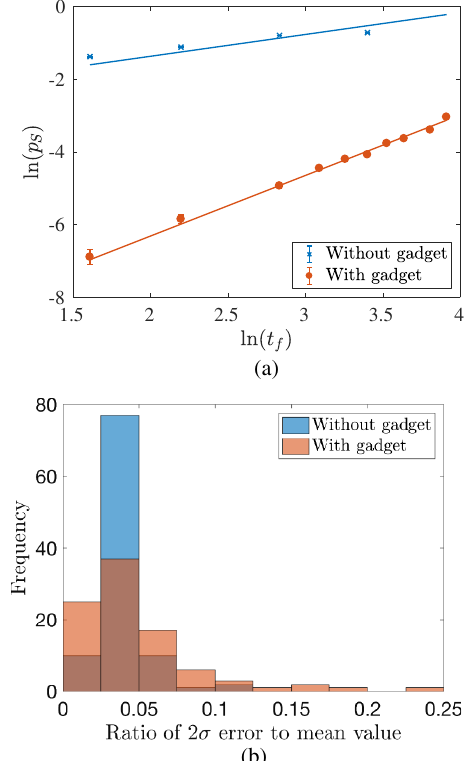
FIG. 19. Fits of the success probability to a power law. (a) The data points represent the DW2KQ ln ð p results for the logical- S Þ planted instances with (red circles) or without (blue crosses) the ∈ ½ 5 ; 50 (cid:2) μ s. The solid lines correspond gadget over the range t f b , where a ¼ 1 . 546 (cid:5) 0 . 015 , b ¼ to the linear best fits a ln ð t f Þ þ − 8 . 348 (cid:5) 0 . 052 (with the gadget), and a ¼ 0 . 367 (cid:5) 0 . 007 , b ¼ − 1 . 918 (cid:5) 0 . 019 (without the gadget). The 2 σ error bars are not visible as they are smaller than the data marker size. (b) The ratio of the 2 σ error to the best-fit value of the linear coefficient (shown in Fig. 7 of the main text) for 100 instances of the logical-planted instances without (blue) and with (red) the